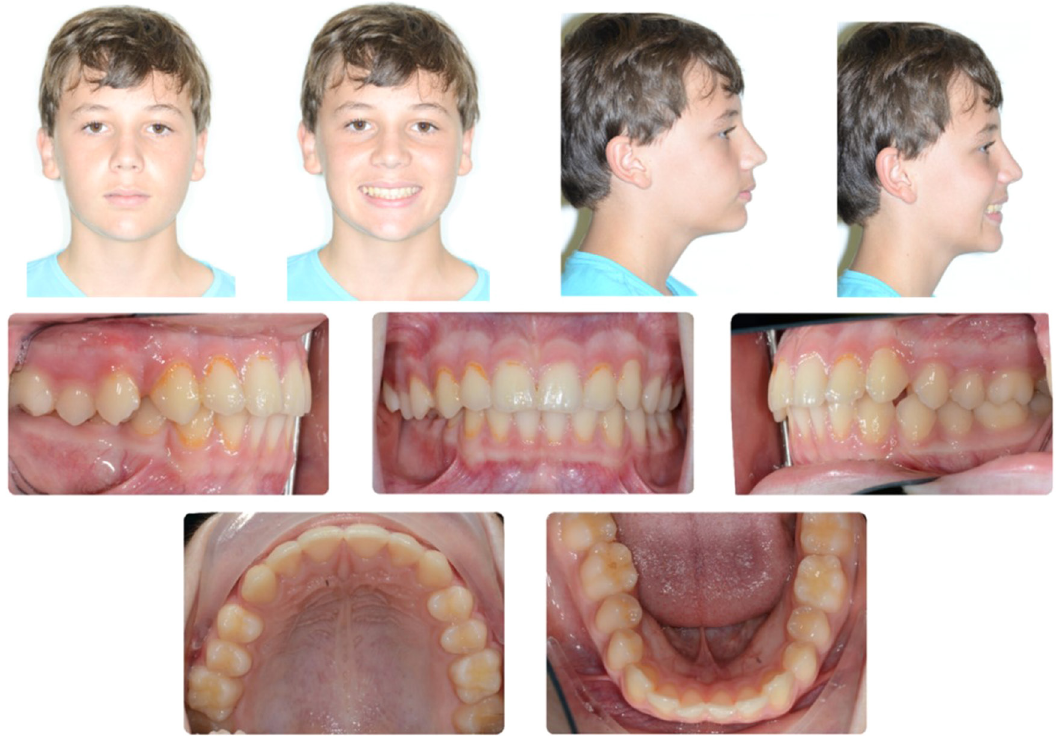
Figure 1. Pre-treatment